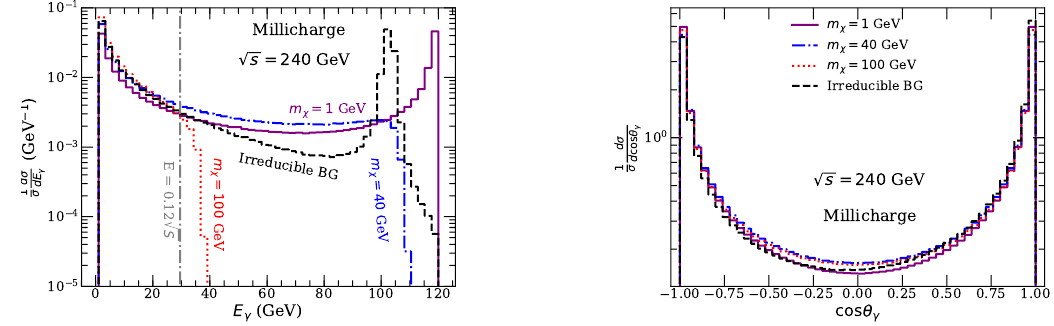
Figure 7 . Normalized E (cid:13) (left) and cos (cid:18) (cid:13) (right) distributions for the e + e (cid:0) ! (cid:31) (cid:22) (cid:31)(cid:13) processes in millicharged DM models, and for the e + e (cid:0) ! (cid:23) (cid:22) (cid:23)(cid:13) processes in SM. Events in 50 bins with equal width on both plots are computed in the CEPC H -mode ( E (cid:13) > 0 : 1 GeV and j cos (cid:18) (cid:13) j < 0 : 99. For the millicharged models, we consider three di(cid:11)erent masses: m (cid:31) = 1 GeV, 40 GeV, and 100 GeV for " = 0 : 01. The photon energy bin width on the left panel (cid:12)gure, (cid:24) 2.4 GeV, is larger than the photon energy resolution which is (cid:14)E (cid:13) ’ 1 (0.3, 0.1) GeV for E (cid:13) = 100 (10, 1) GeV, according to eq. (3.8). The vertical line E = 0 : 12 of the detector cut designed to remove the reducible